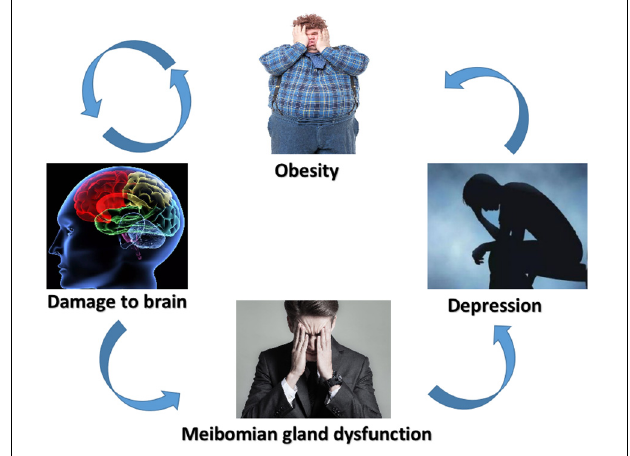
FIGURE 6 | Schematic diagram of the relationship between SM, brain damage, MGD, and depression. SM, severe obesity and meibomian gland dysfunction; MGD, meibomian gland